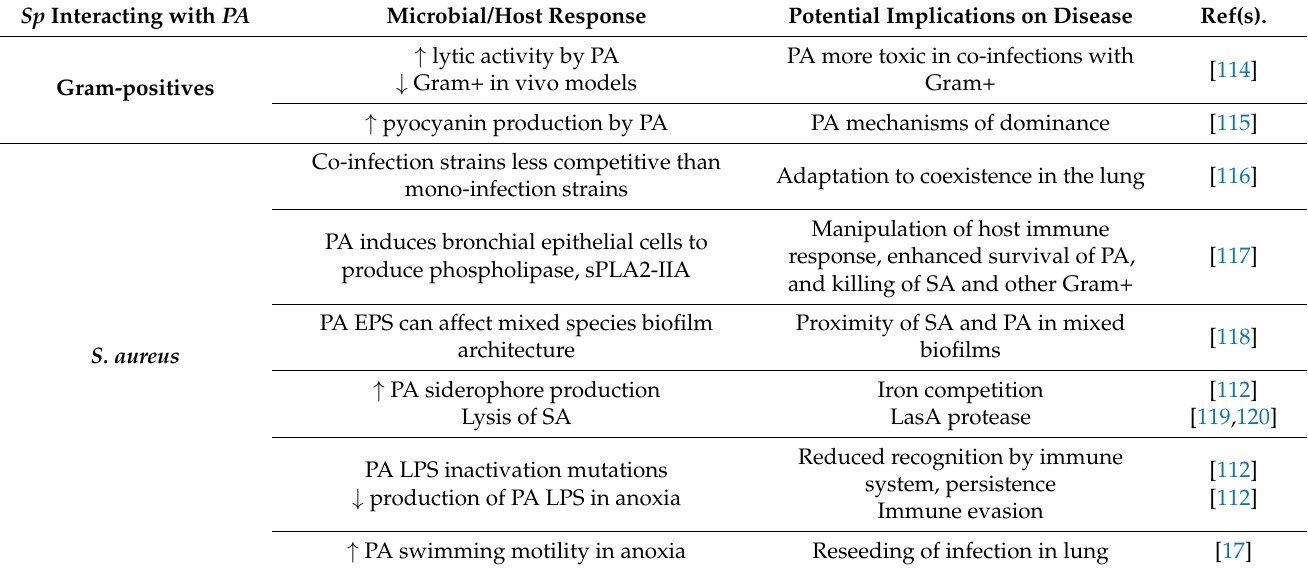
Table 1. Studies reporting microbial interactions with P. aeruginosa . Sp Interacting with PA